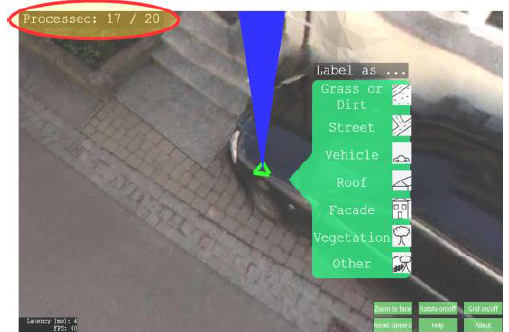
Figure 6 . A progress bar shows how many triangles have already been labelled.